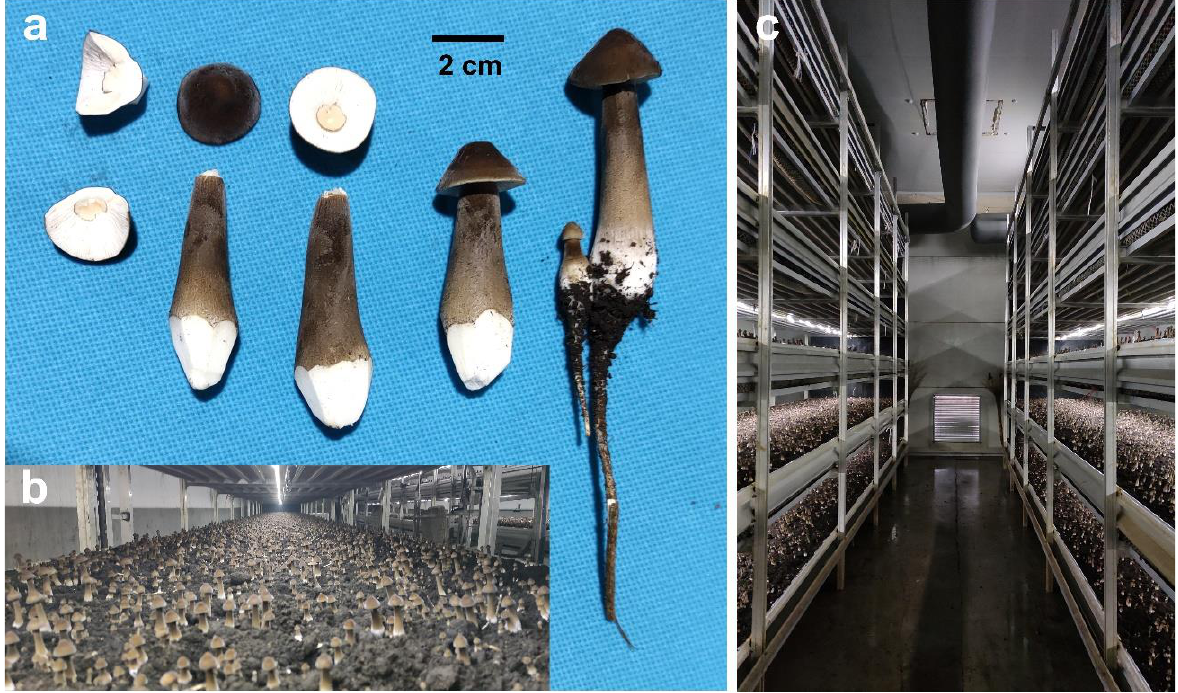
Figure 1. The fruiting bodies of O. raphanipes CGG-1 . ( a ) The fruiting body morphology of O. raphanipes . ( b ) Industrial cultivation of O. raphanipes. ( c ) The greenhouse for industrial cultivation of O. raphanipes . ( b ) Industrial cultivation of O. raphanipes . ( c ) The greenhouse for industrial cultivation O. raphanipes. of O. raphanipes